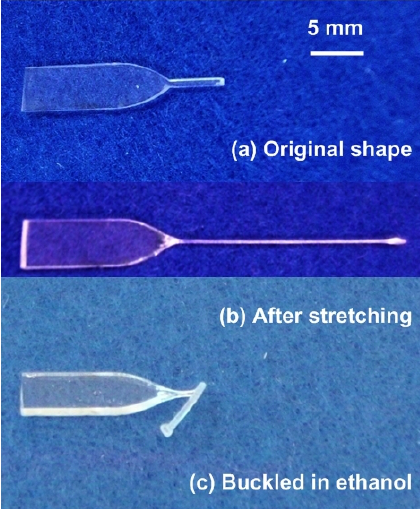
Figure 11. Buckling of PMMA. ( a ) Original shape; ( b ) after pre-stretching at high temperatures; and ( c ) after immersing into room temperature ethanol for a few